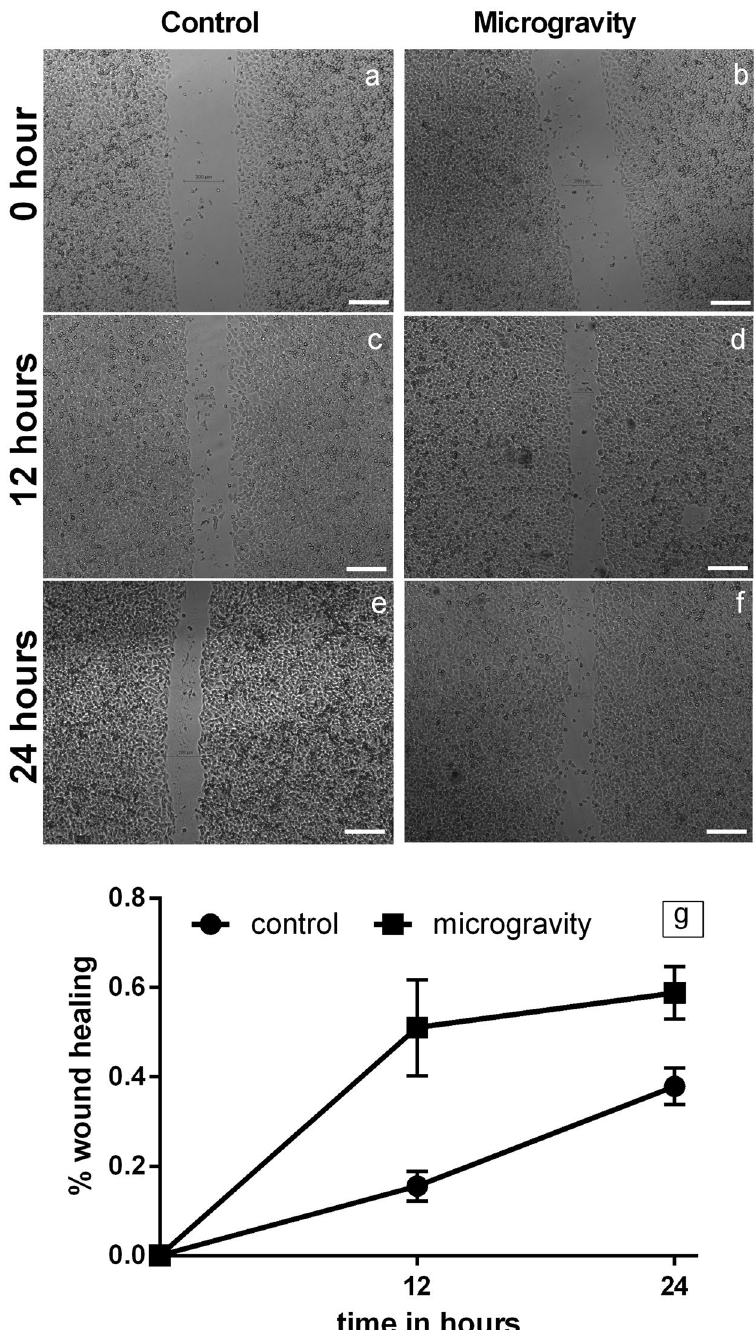
Figure 6. Microgravity increases cell migration. Phase contrast image of DLD1 control cells immediately after scratch from a T200 tip ( a ), 12 h post scratch wound ( c ) and 24 h post scratch wound ( e ). Comparative phase contrast image of SM DLD1 2 weeks post shifting to normal gravitational condition, 0 h ( b ), 12 h ( d ) and 24 h ( f ), scale = 200 μ m. The representative graph ( g ) depicts 57.7% wound healing in SM after 12 hours, compared to 15.5% in control. The wound healing was 59% after 24 hours in SM compared to 38% in